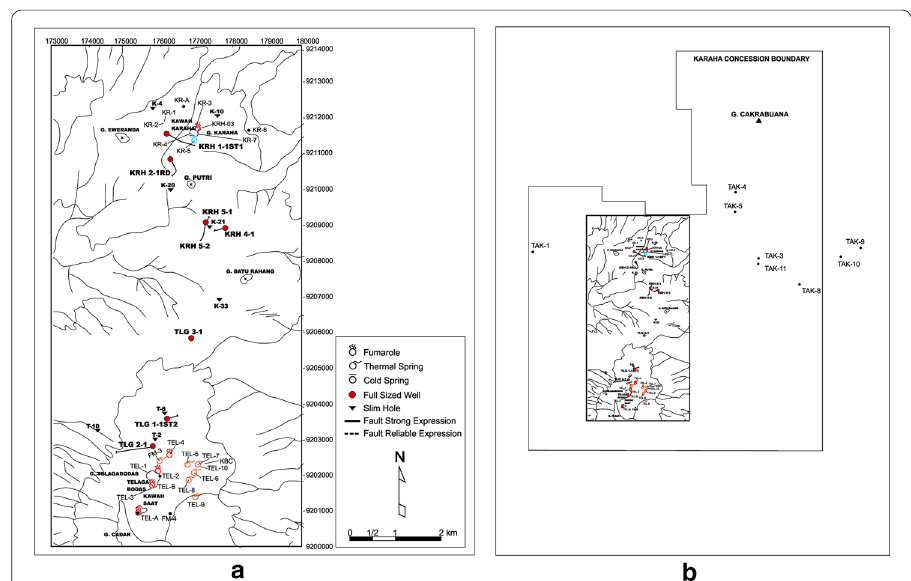
Fig. 4 Map of the distribution of volcanic features, thermal manifestations, fluid sampling and wells in the area of K–TB field (Geothermex